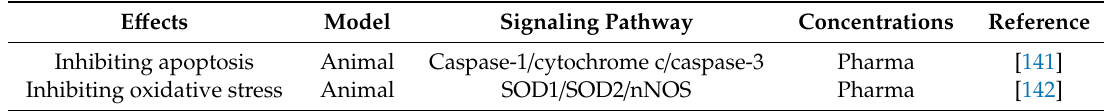
Table 5. Melatonin and amyotrophic lateral